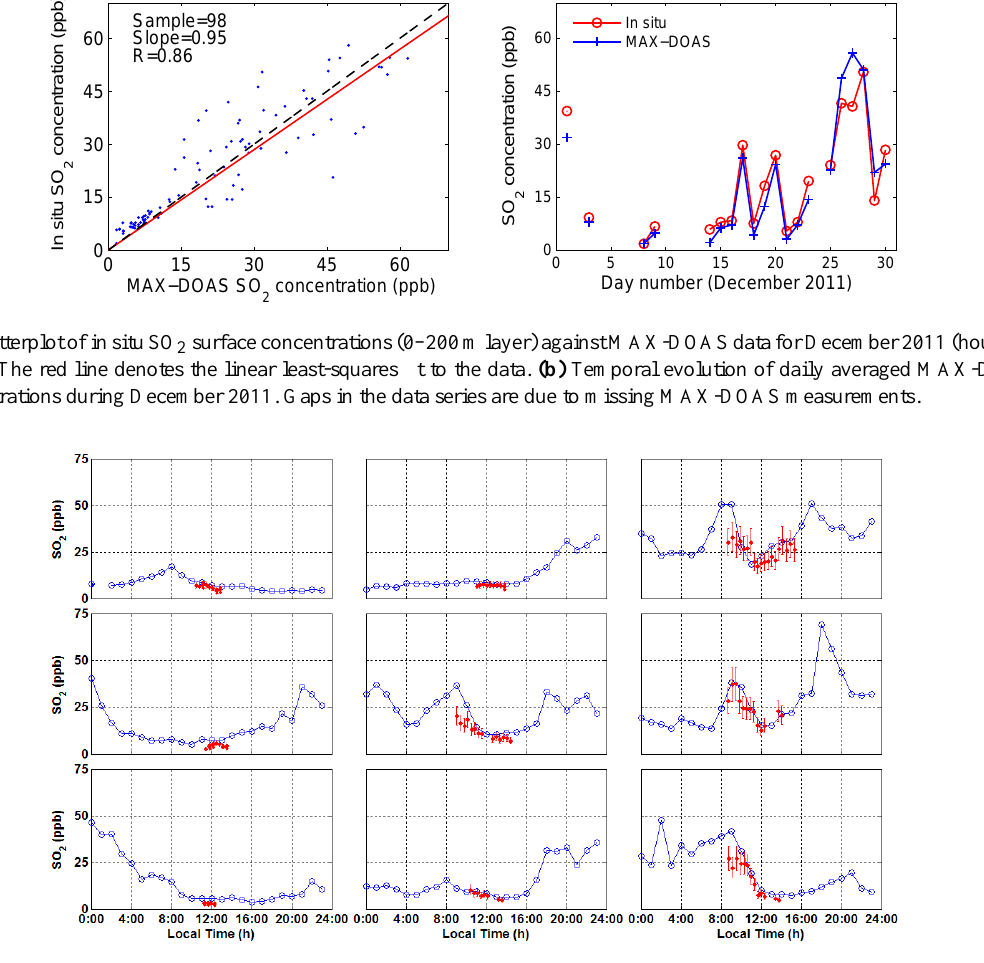
Figure 9. Comparison between in situ (blue, hourly means) and MAX-DOAS SO 2 surface concentrations (red, each point represents the retrieval from one scan) for the 15–23 December 2011 period (upper plots are for 15–17 December, middle plots for 18–20 December, and lower plots for 21–23